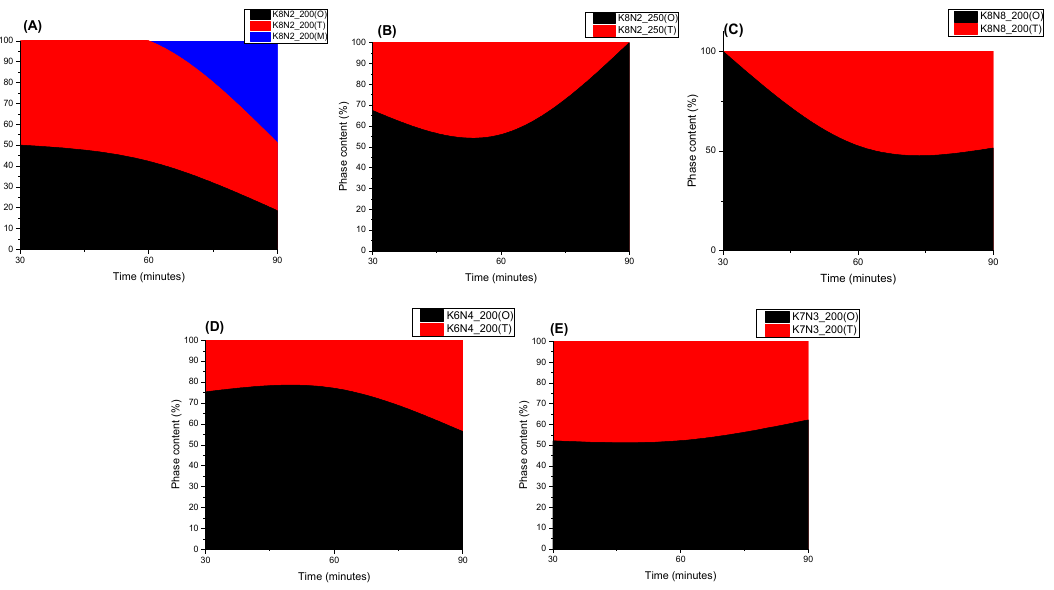
Figure 6. Monoclinic, orthorhombic and tetragonal phase content of HTMW-synthetized powders in series K8N2_200 ( A ), K8N2_250 ( B ), K8N8_200 ( C ), K6N4_200 ( D ) and K7N3_200 ( E ), for 30–90 min.